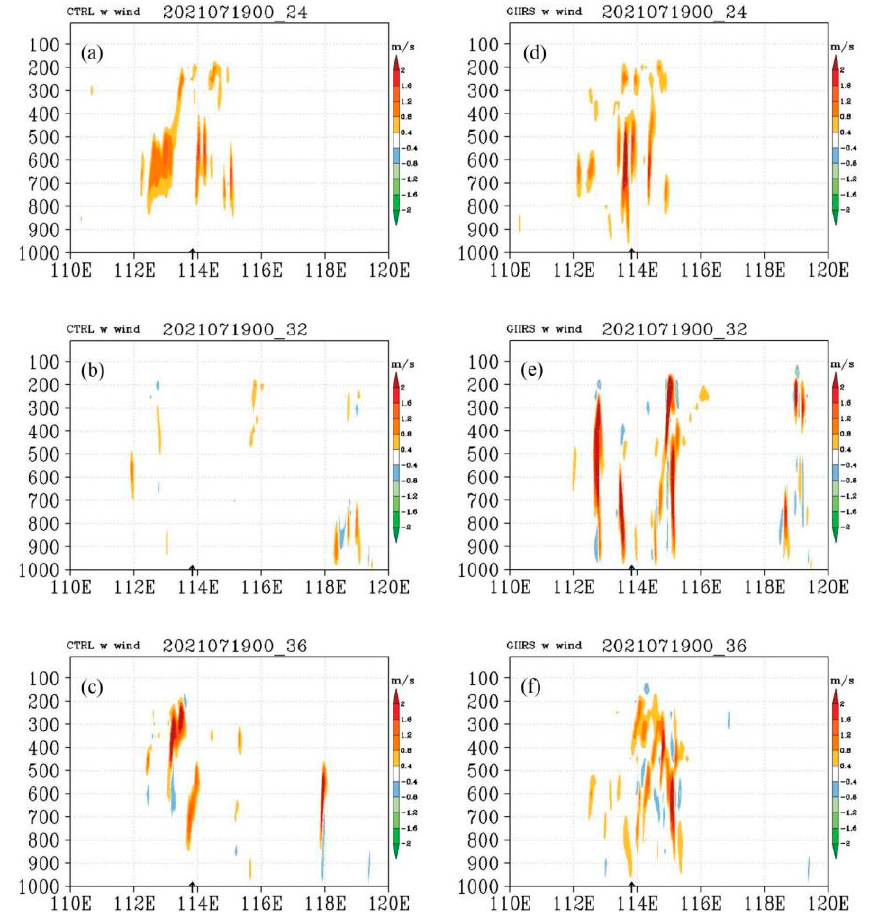
Figure 8. Vertical cross sections of w wind (m s − 1 ) of the CTRL experiment along 34.71°N at 0000 UTC ( a ), 0800 UTC ( b ), and 1200 UTC ( c ), on 20 July 2021 (24 ‐ h, 32 ‐ h and 36 ‐ h forecasts initialized from 0000 UTC on 19 July 2021). ( d – f ) are the same as ( a – c ), but for the GIIRS experiment. The black arrow indicates Zhengzhou Station (113.66°E, 34.71°N).